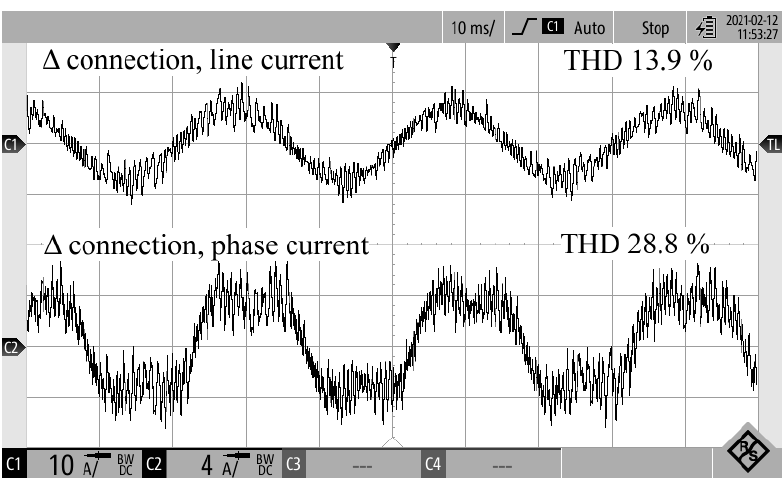
Figure 14. Line and phase current comparison for a delta winding connection; reference speed 1000 RPM, reference stator flux 1.7 Wb, load torque 0 Nm.